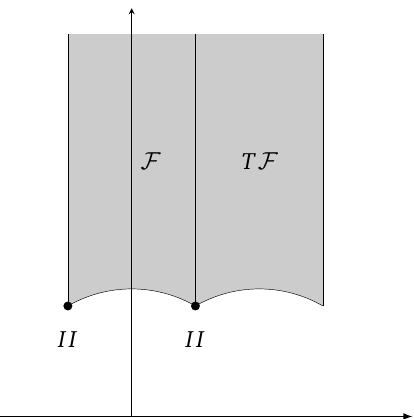
Figure 9: Fundamental domain for the ( I ∗ = 2 4 d SU ( 2 ) N f